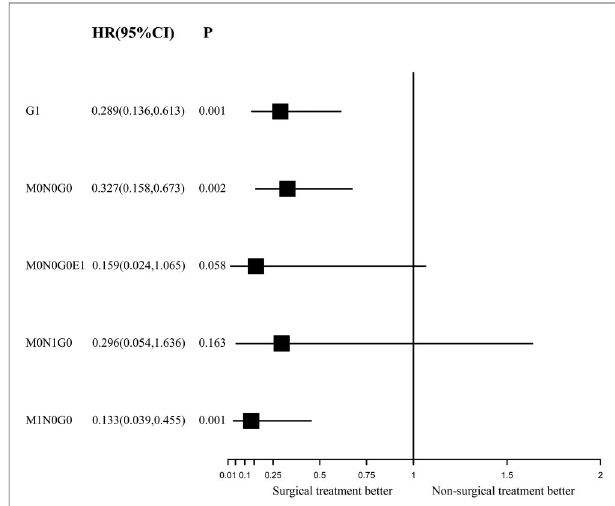
FIGURE 5 | Forest plot depicting inverse probability of treatment weighting – adjusted hazard ratios of all-cause mortality in different subgroups of surgery versus non-surgery. The multivariable model was constructed with pre- speci fi ed variables (surgery, sex, age) to avoid over fi tting, considering the limited number of outcomes.